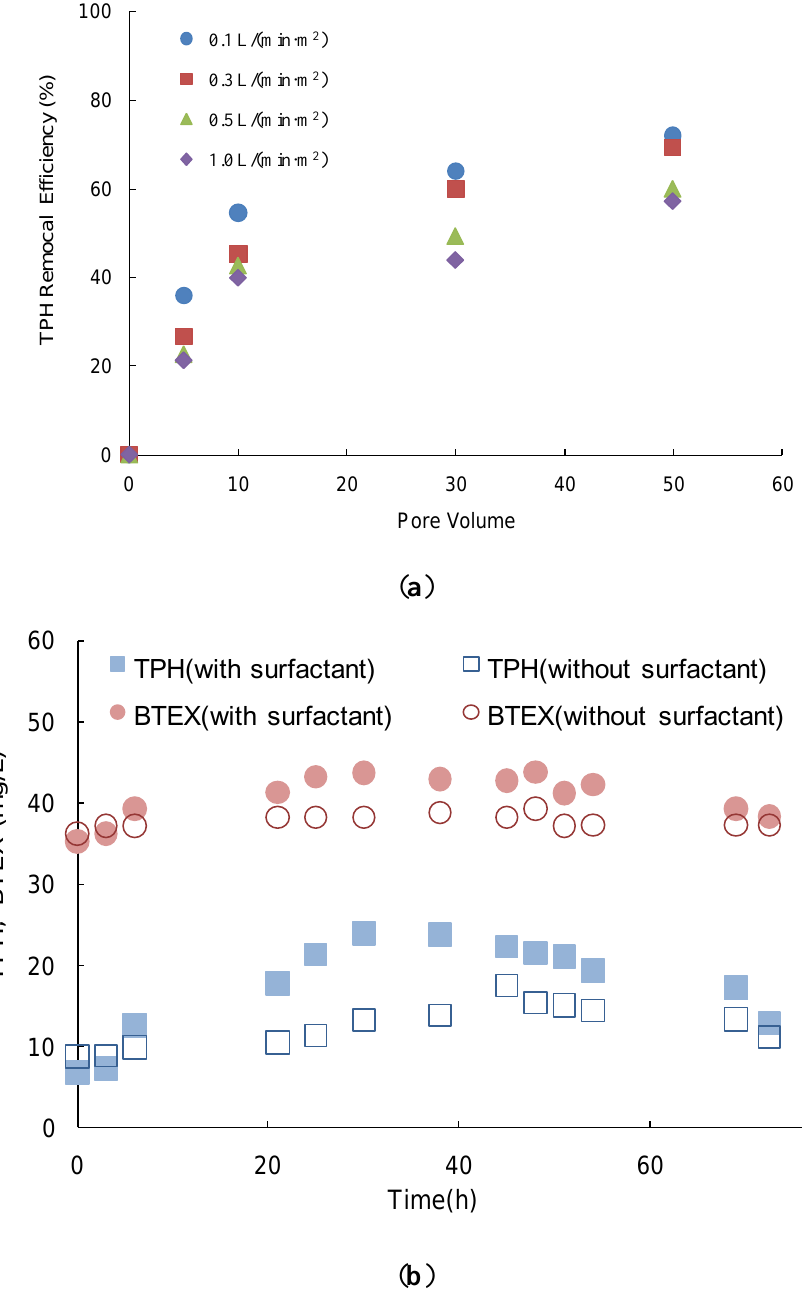
Figure 5. Variations in the TPH and BTEX concentrations during the soil flushing operation. ( a ) TPH removal efficiency at 0.1, 0.3, 0.5, and 1.0 L/min∙m 2 in the column test, ( b ) the TPH and BTEX concentrations during the pilot scale soil flushing operation with and without the